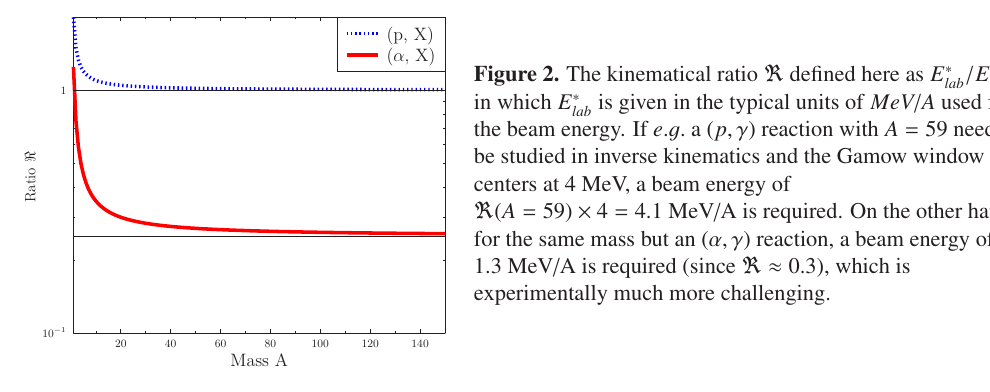
Figure 1. Typical Gamow window energy ranges for ( p ,γ ) reactions for di ff erent astrophysical processes. Other reactions involved in the particular process are also shown. The expected